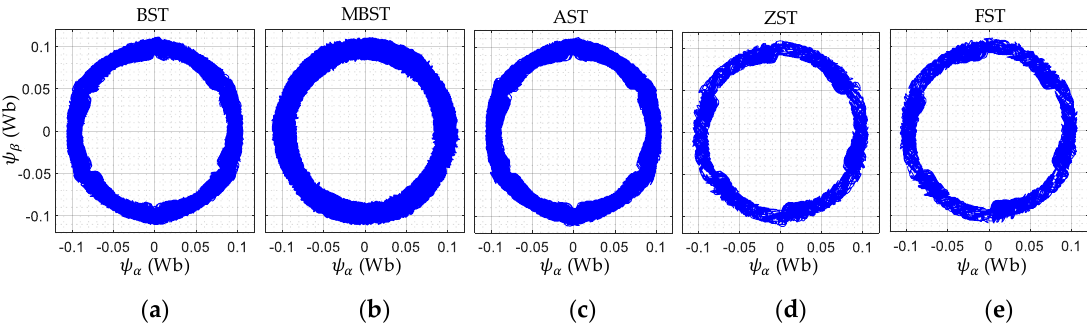
Figure 7. Experimental results of the steady-state response of stator flux at 1000 rpm and 1 Nm load: